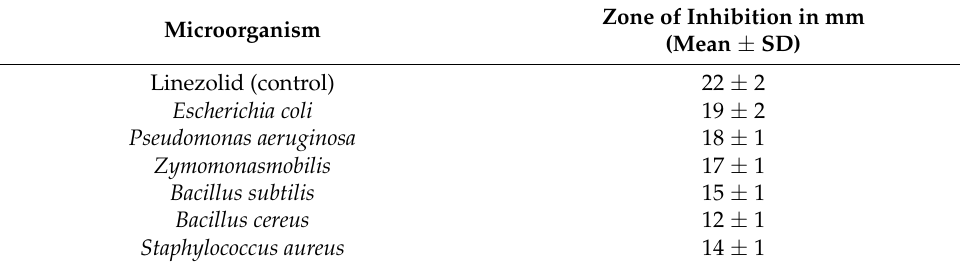
Figure 9. Antibacterial activity of ZnONPs on Gram-positive and Gram-negative bacteria. Table 4. Antibacterial activity with a zone of inhibition